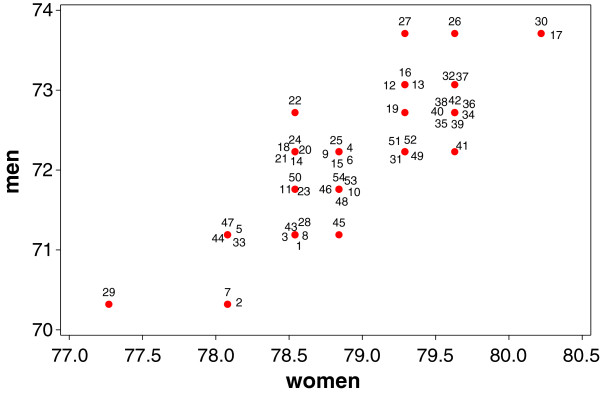
Scatterplot of life-expectancy level αj(i)wfor women against the life-expectancy levelαj(i)mfor men of region i, j(i) is the component j into which the region i is classified.